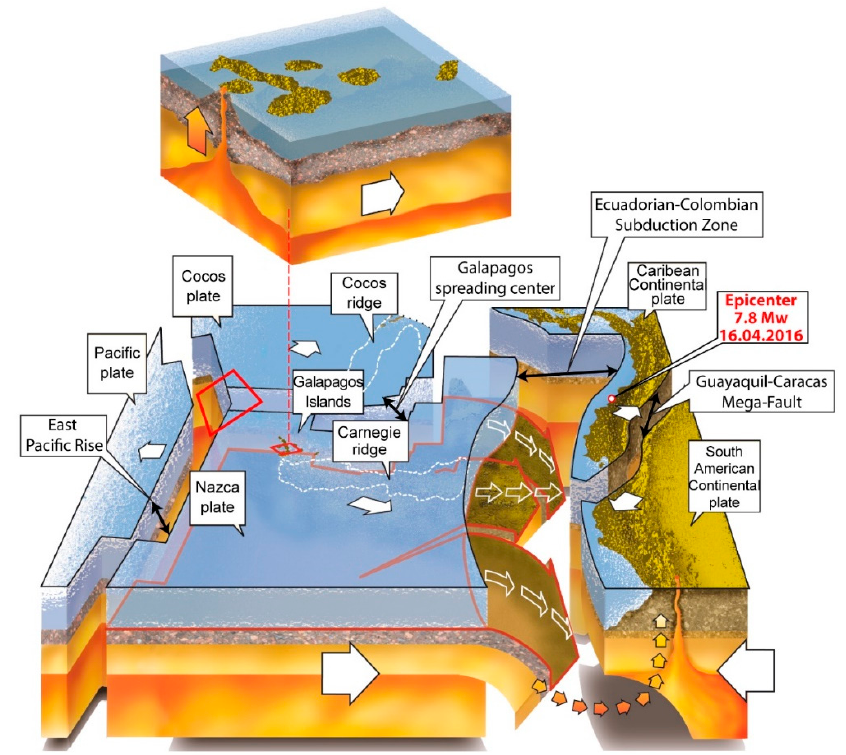
Figure 1. Geodynamic setting of Ecuador, the Galapagos Islands and the Carnegie Ridge; modified after [25].